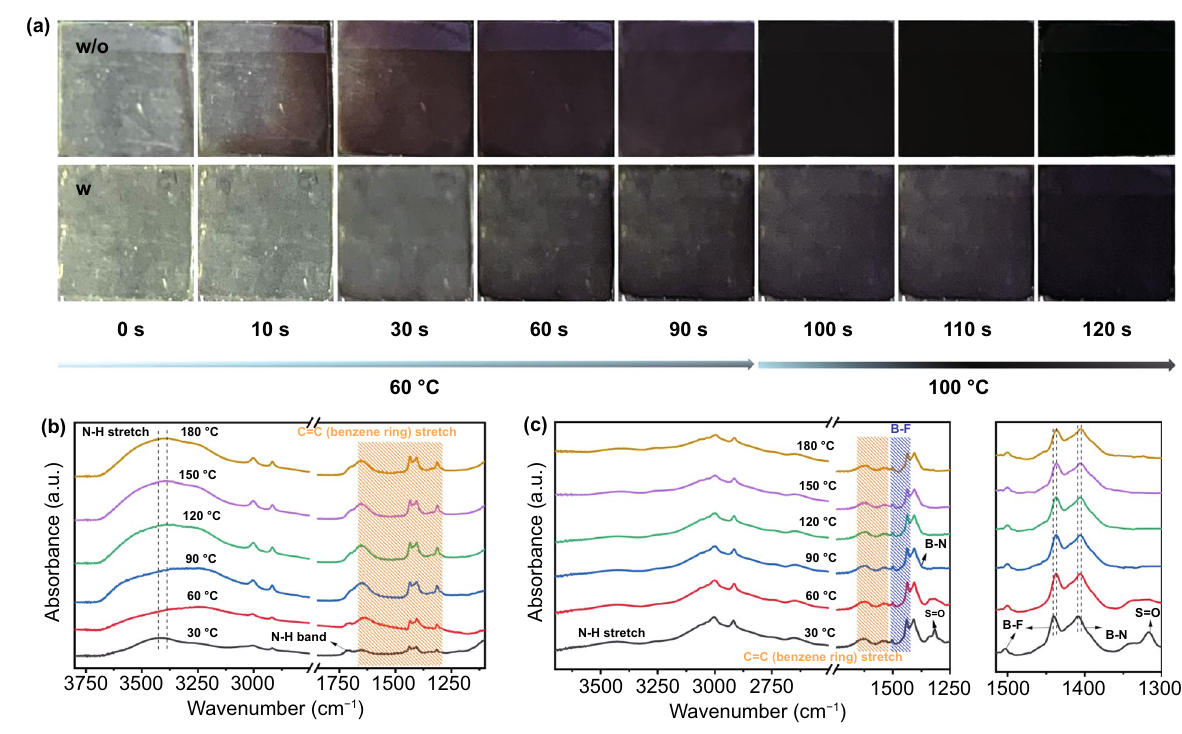
Fig. 1 a Photographs of perovskite precursor films without and with 1.5 mg mL −1 BBF additive annealed at 60 °C/100 °C for different times. FTIR spectra of b the FAI precursor film with BBF additive and c the PbI 2 precursor film with BBF additive annealed for 60 s at different tem- peratures in ambient air (RH: 30%, T: 25